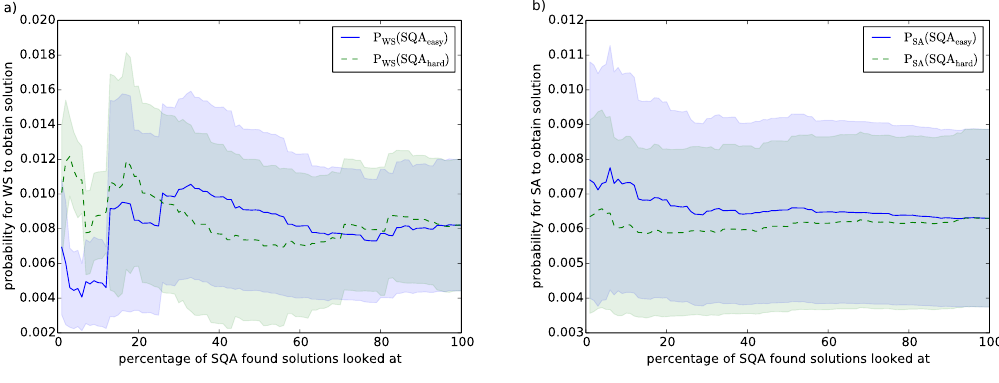
Figure 9: Average efficiency of a 3-SAT filter with a clauses-to-variables-ratio of α χ The solutions used to construct the filter were chosen randomly from the found solutions.